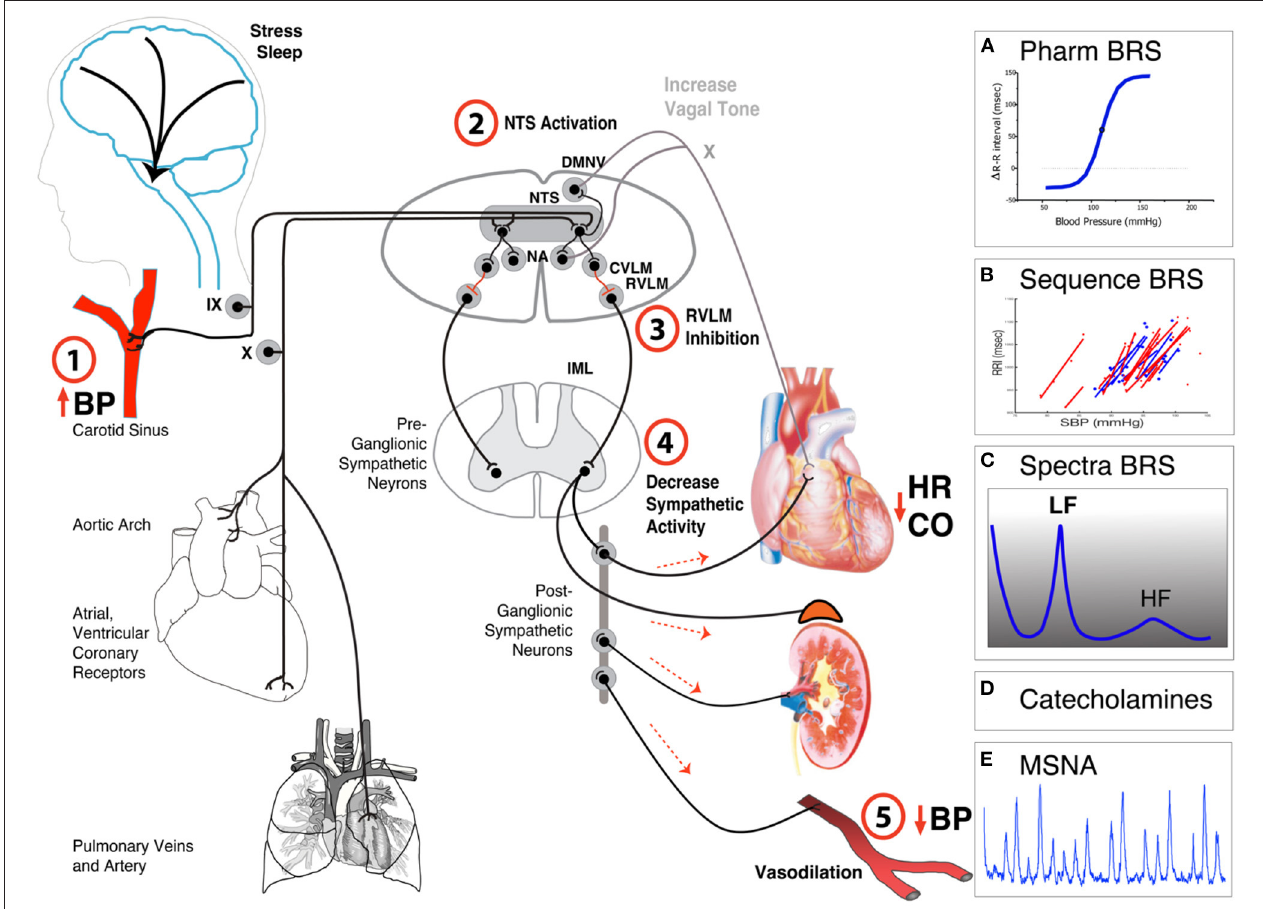
FIGURE 1 | Simplified anatomical and functional scheme of baroreflex function. Baroreceptors in the carotid sinus, aortic arch, right atrium and in the cardiopulmonary veins are activated-by (1) stretching and passing this information through the Vagus (X) or glossopharyngeal (IX) nerves to (2) the nucleus tractus solitarii (NTS) of the brain stem. The NTS projects to neurons in caudal ventrolateral medulla (CVLM) which (3) inhibits sympathetic pacemaker neurons in the rostral ventrolateral medulla (RVLM) and (4) reduces sympathetic outflow. This decreases heart rate, cardiac output, and (5) blood pressure. Activation of the NTS projects also to the nucleus ambiguous (NA) and dorsal motor nucleus of the Vagus (DMNV) and increases parasympathetic activity. Common methods to evaluate baroreflex function include (A) pharmacological challenge with vasoactive drugs, (B) spontaneous sequence analysis, (C) spectral analysis, (D) measurements of catecholamines, or (E) muscle sympathetic activity (MSNA) during orthostatic